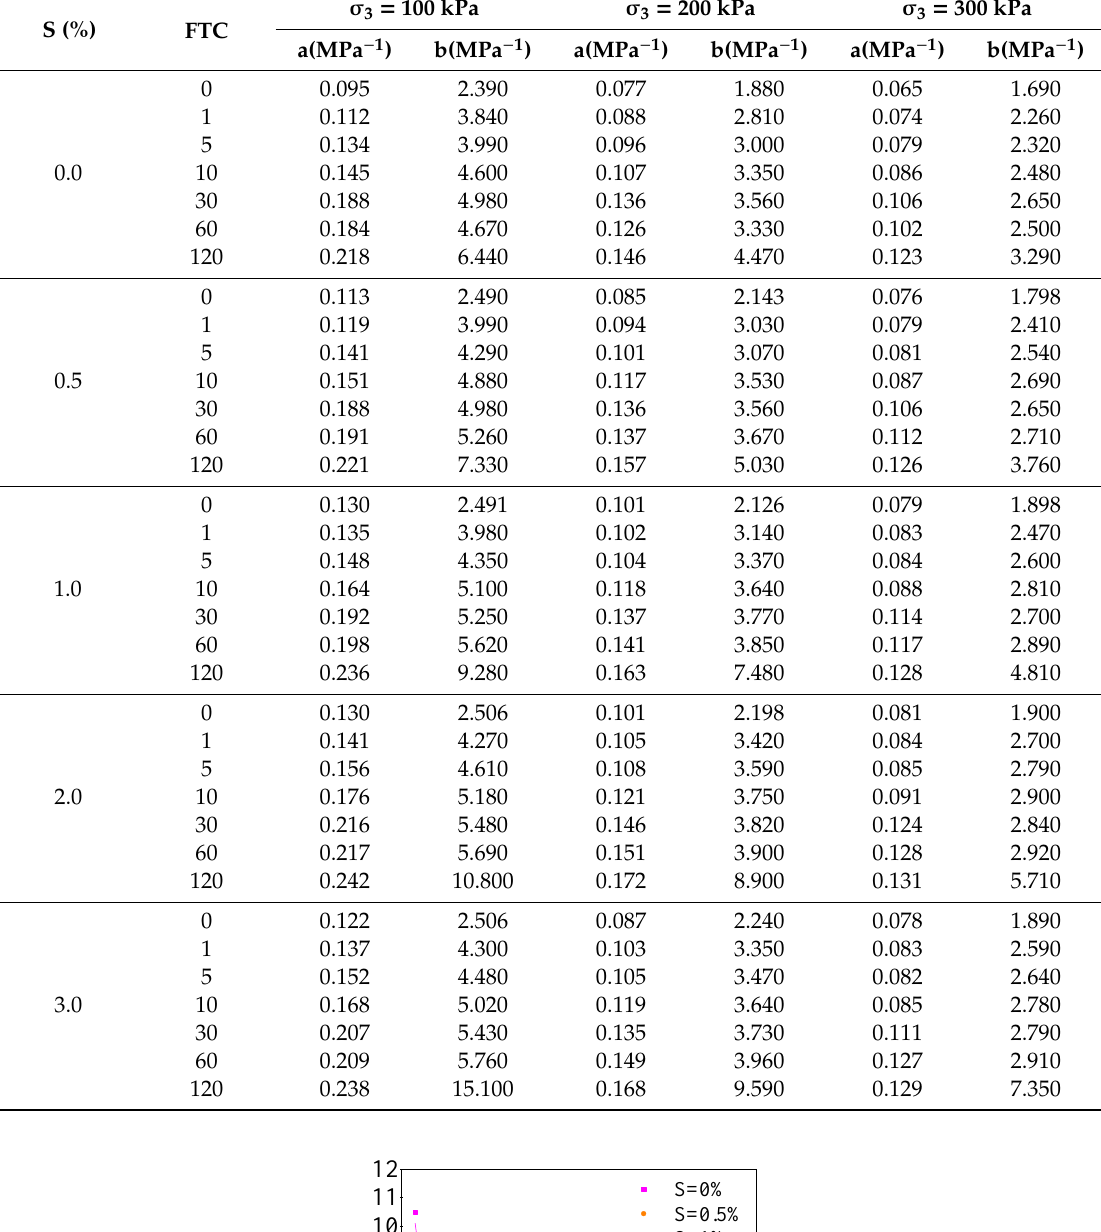
Table 6. Parameters a and b of curves ε 1 / ( σ 1 − σ 3 ) - ε 1 under di ff erent